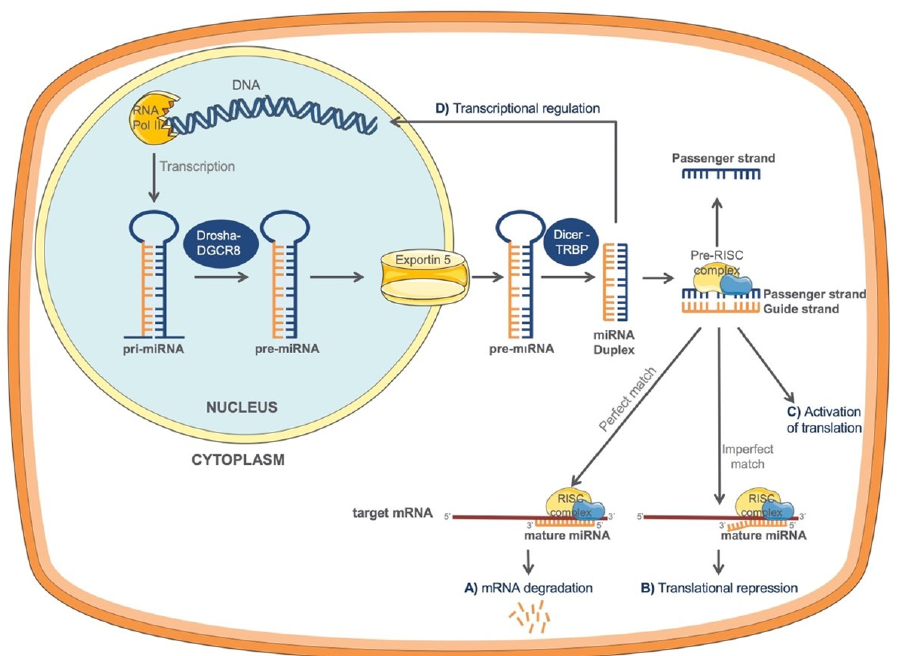
Figure 1. miRNAs biogenesis and post-transcriptional gene regulation mechanisms. In the nucleus, genomic DNA is transcribed by RNA polymerase II to form a pri-miRNA. pri-miRNA is recognized and cleaved by the complex composed of RNase III Drosha and DGCR8 to generate pre-miRNA. Pre-miRNA is exported into the cytoplasm by exportin-5 RanGTP and further cleaved by Dicer-TRBP to generate miRNA duplex. This duplex is loaded onto the pre-RISC complex, where consequently only one strand (“guide strand”) will stay to form the RISC complex. The guide strand will lead the mature RISC complex to a nearby 3 ′ UTR complementary sequence of the target mRNA. If miRNA and its target mRNA establish the perfect match, a direct mRNA degradation will occur ( A ). Alternatively, an imperfect match between miRNA and its target mRNA will lead to a translational repression and a decrease in protein levels of the target gene ( B ). In certain conditions, miRNAs can activate translation of target mRNA ( C ). miRNAs could also be found in the nucleus regulating gene transcription ( D ), either by silencing or activating target genes through miRNA-binding sites within the gene promoters. DGCR8, DiGeorge syndrome critical region 8 cofactor; TRBP, transactivating response RNA-binding